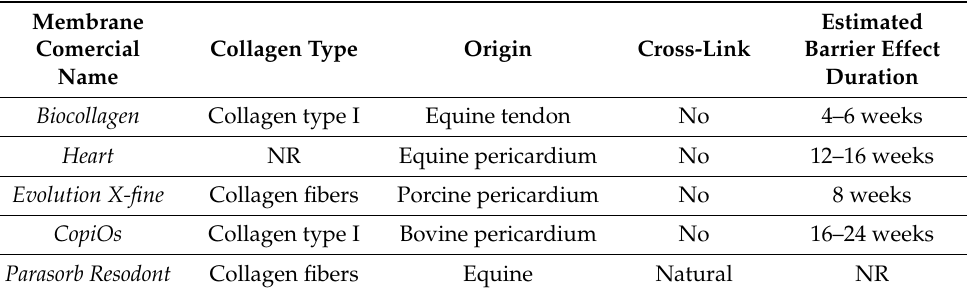
Table 1. Commercial name, collagen type, collagen origin and clinical characteristics (cross-link, estimated duration of the barrier effect) of the tested collagen membranes. The information was obtained from the membrane